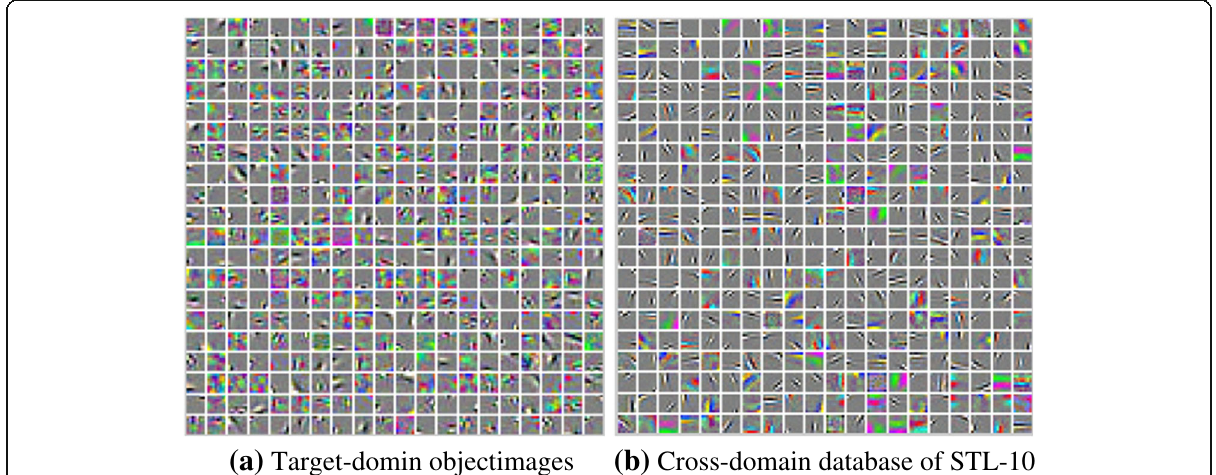
Fig. 6 The visualizing displays of the higher layer local eigenvectors extracted by the SAE model. The left side of the figure shows the higher layer local eigenvectors extracted by the SAE model from ( a ) The target-domain object images, and the right side of the figure shows the higher layer local eigenvectors extracted by the SAE model from ( b ) The cross-domain database of